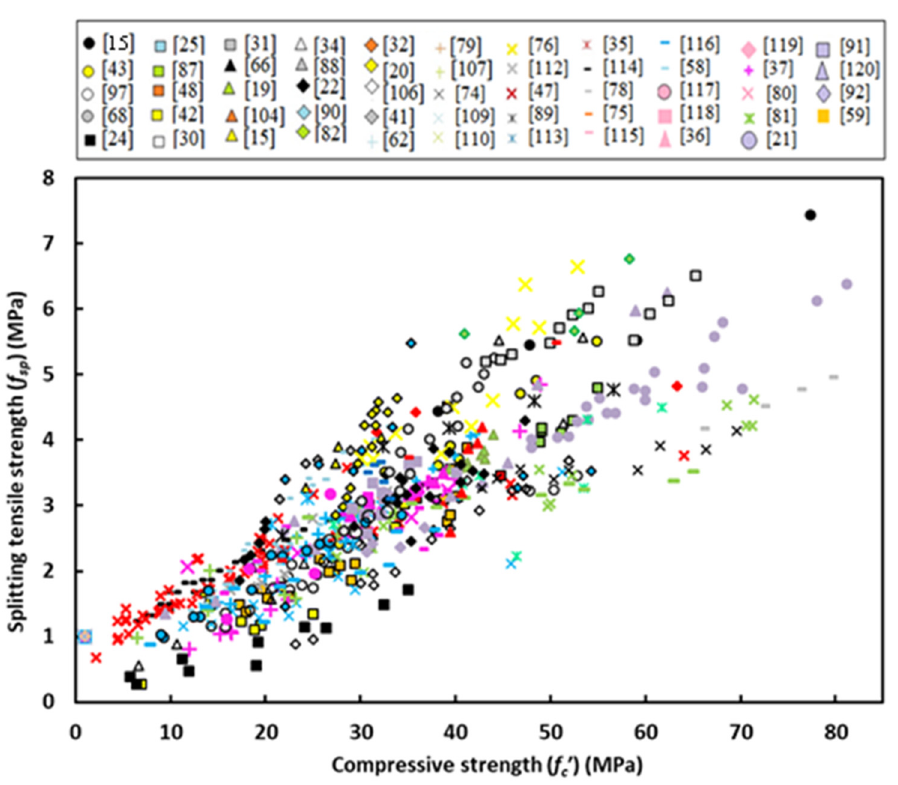
Figure 2. Variation of splitting tensile strength with compressive strength of GPC.